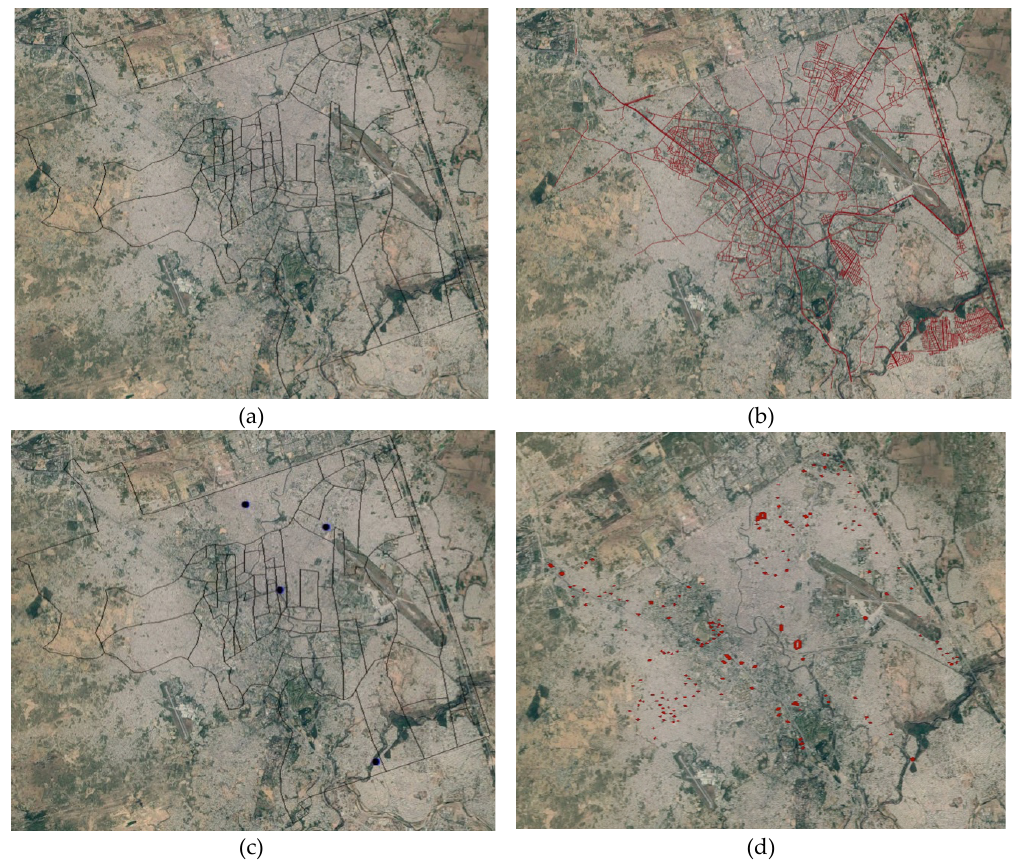
Figure 4. Area boundaries ( a ), road networks ( b ), resources center ( c ), and digitalized building node ( d